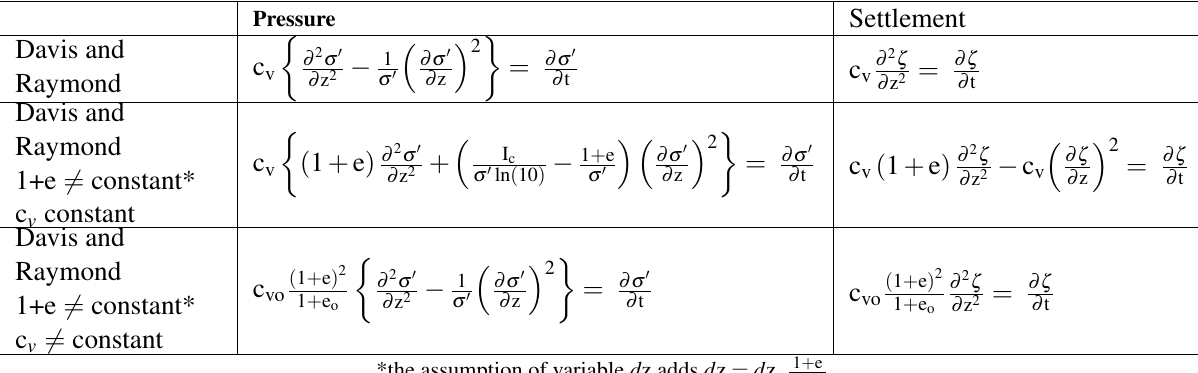
Table 1 Governing equations for the different variants of the Davis and Raymond